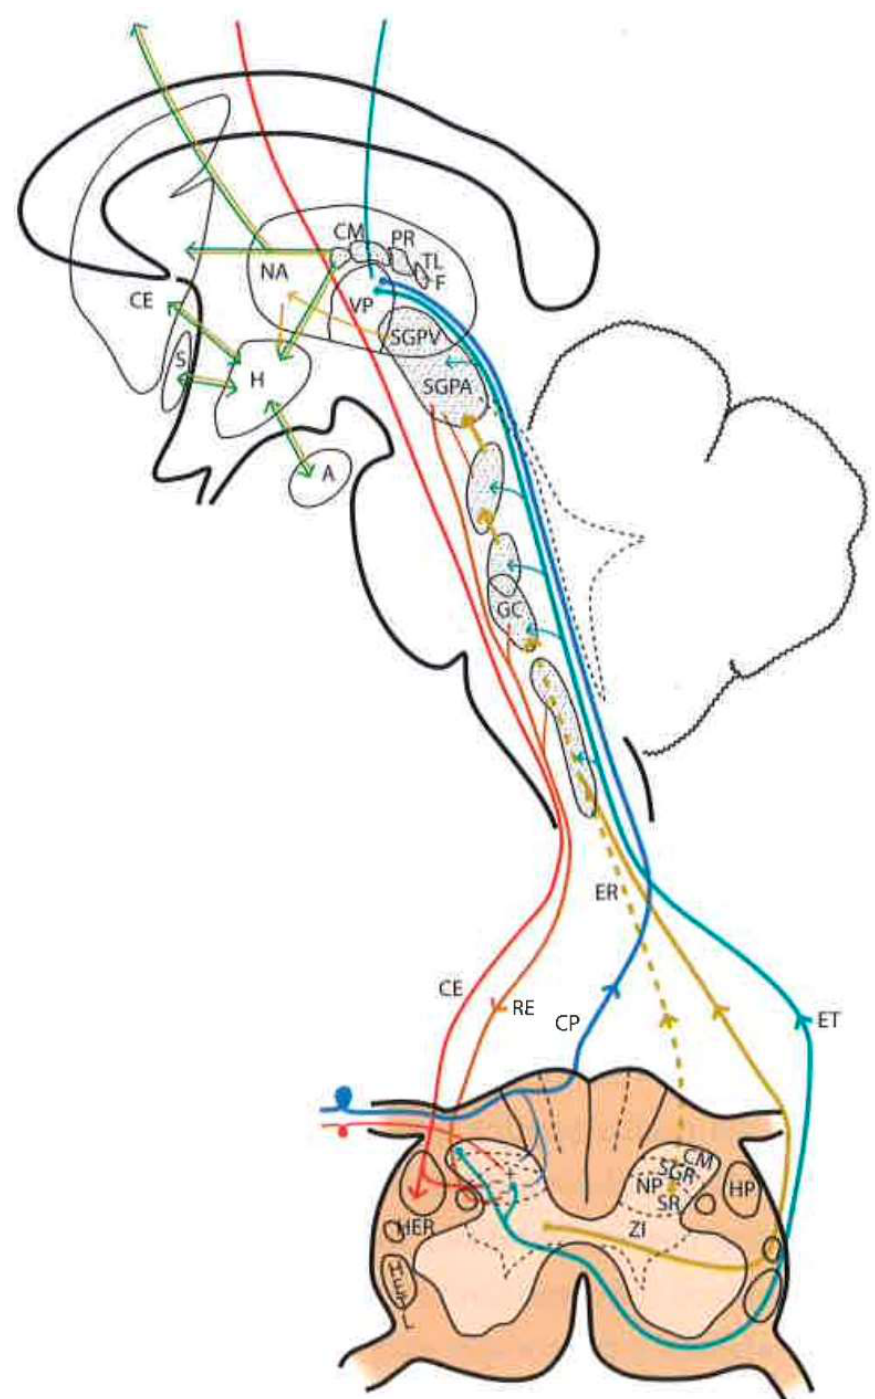
Figure 2. Diagram of the distribution of the main sensory pathways involved in pain perception and control (see text). (Taken from [16]). SGPV = PVG (Periventricular Gray Matter). SGPA = PAG (Periaqueductal Gray Matter). H = H (Hypothalamus). CE = CS (Corticospinal), RE = RS (Reticulospinal), ER = SR (Spinoreticular) and HETL = LSTT (Lateral spinothalamic) Tracts. NP = PN (Pulvinar nucleus). GM = MG (Medial geniculate nucleus).